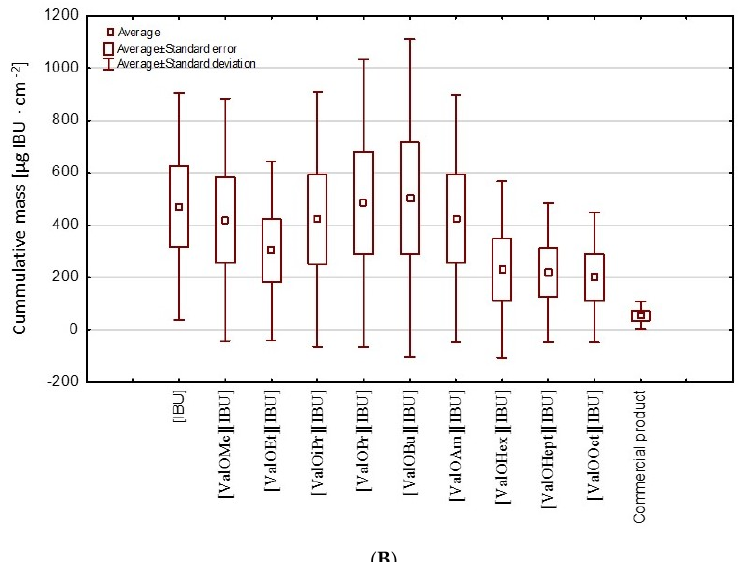
Figure 4. A box plot of the average cumulative mass of [IBU] and its derivatives after 24 h penetration from hydrogel preparations through ( A ) human skin and ( B ) Strat-M™ membranes.